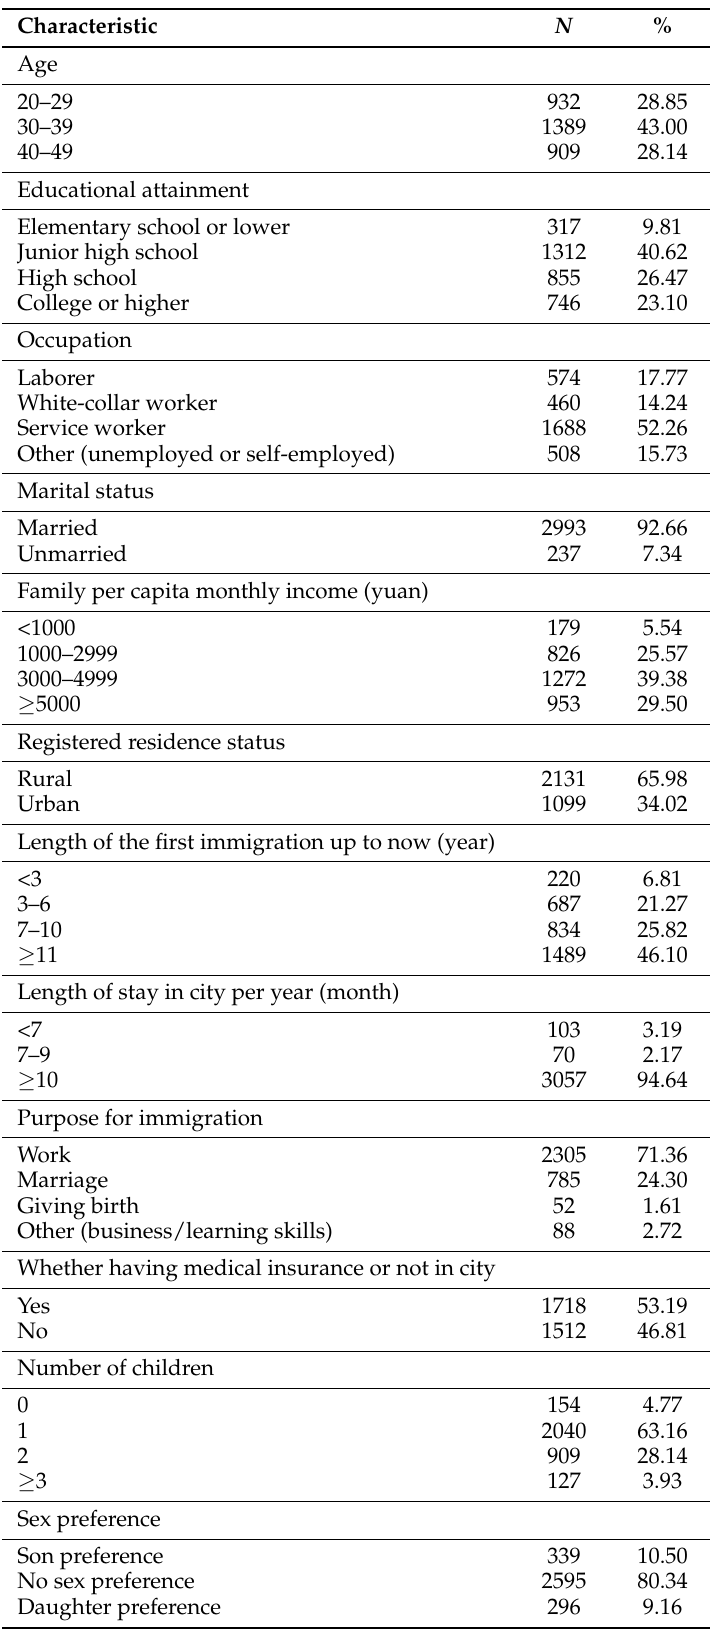
Table 1. Socio-demographic characteristics of the study subjects ( N =